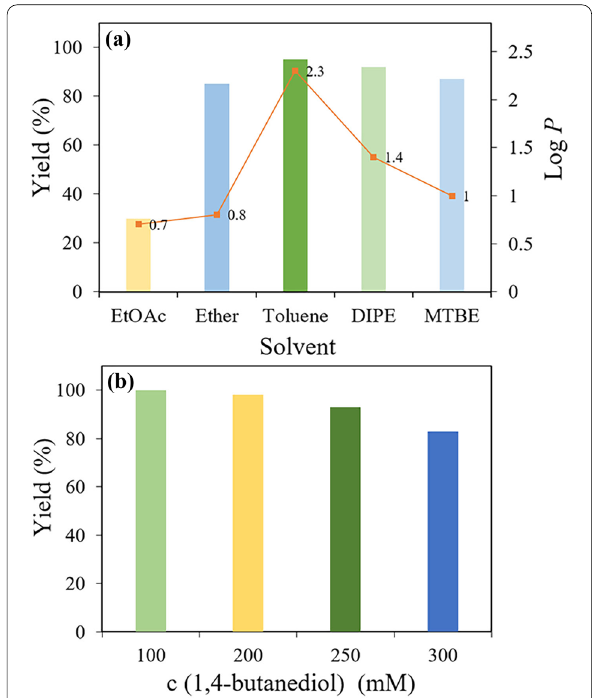
Fig. 4 HLADH-catalyzed oxidation lactonization of 1,4-BD in a two-liquid phase system (2LPS). Standard reaction conditions: NAD + (0.1 mM), SBFC (0.05 mM), HLADH (0.3 g L − 1 ), and catalase (20 U/mL) in 1 mL of aqueous Tris–HCl buffer (50mM, pH 8.0) at 30 °C. a 1,4-BD (100 mM), and in different organic phase (5 mL), V organic /V aqueous Detection after 24 h. EtOAc ethyl acetate, DIPE diisopropyl ether, MTBE tert-butyl methyl ether. b At different substrate concentrations; organic phase: toluene (1 mL), V organic /V aqueous 48 h. Yields are average values of